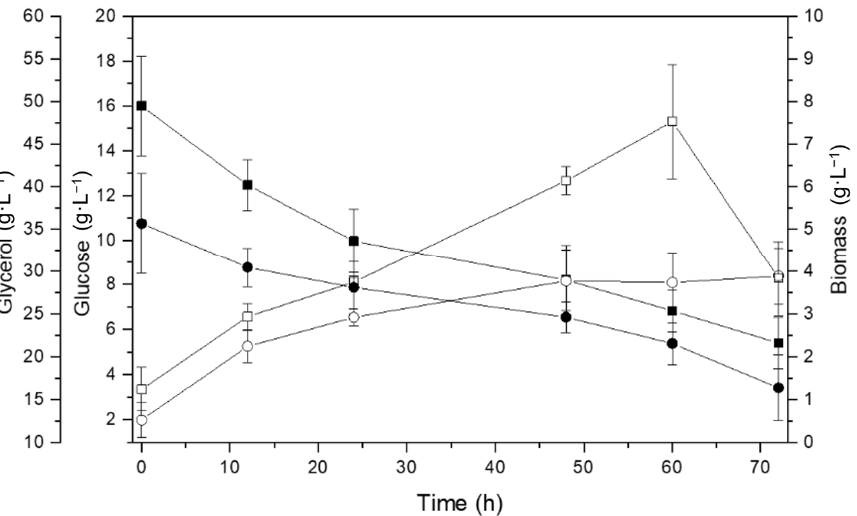
Figure 1. Bacillus megaterium DSMZ 32 kinetics. Glucose concentration ( • ), glycerol concentration ( (cid:4) ), and biomass production using glucose (